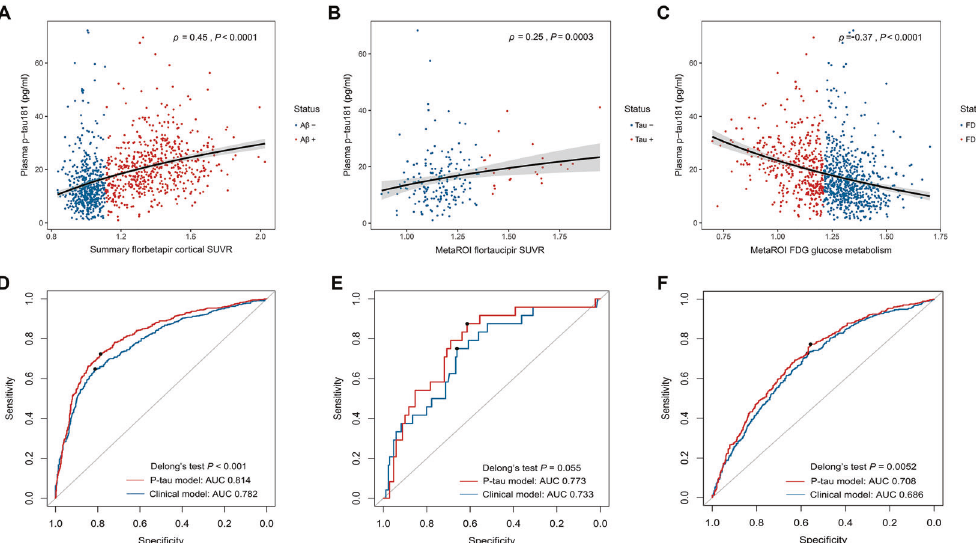
Fig. 2 Relationships of plasma p-tau181 concentration with brain PET uptakes. Scatter fi tting curves ( A – C ) plot the associations of plasma p-tau181 concentration with brain amyloid ( A ), tau ( B ), and FDG ( C ) PET uptakes. Statistical results were generated by the Spearman correlation analyses, and the corresponding curves were roughly smoothed to show directionality. Blue points represent plasma p-tau181 levels of individuals with normal PET uptakes, whereas red points represent those of individuals with abnormal PET uptakes. ROC curves ( D – F ) illustrate the performance of plasma p-tau181 in discriminating brain pathological changes ( D for detecting the abnormal amyloid PET, E for detecting the abnormal tau PET, and F for detecting the abnormal FDG PET). The blue line represents the performance of the clinical model, consisting of age, gender, years of education, and APOE ɛ 4 carriage. The red line represents the performance of the adjusted model which combined plasma p-tau181 and the clinical indicators including age, gender, years of education, and APOE ɛ 4 carriage. ROC receiver operating characteristic; AUC area under the